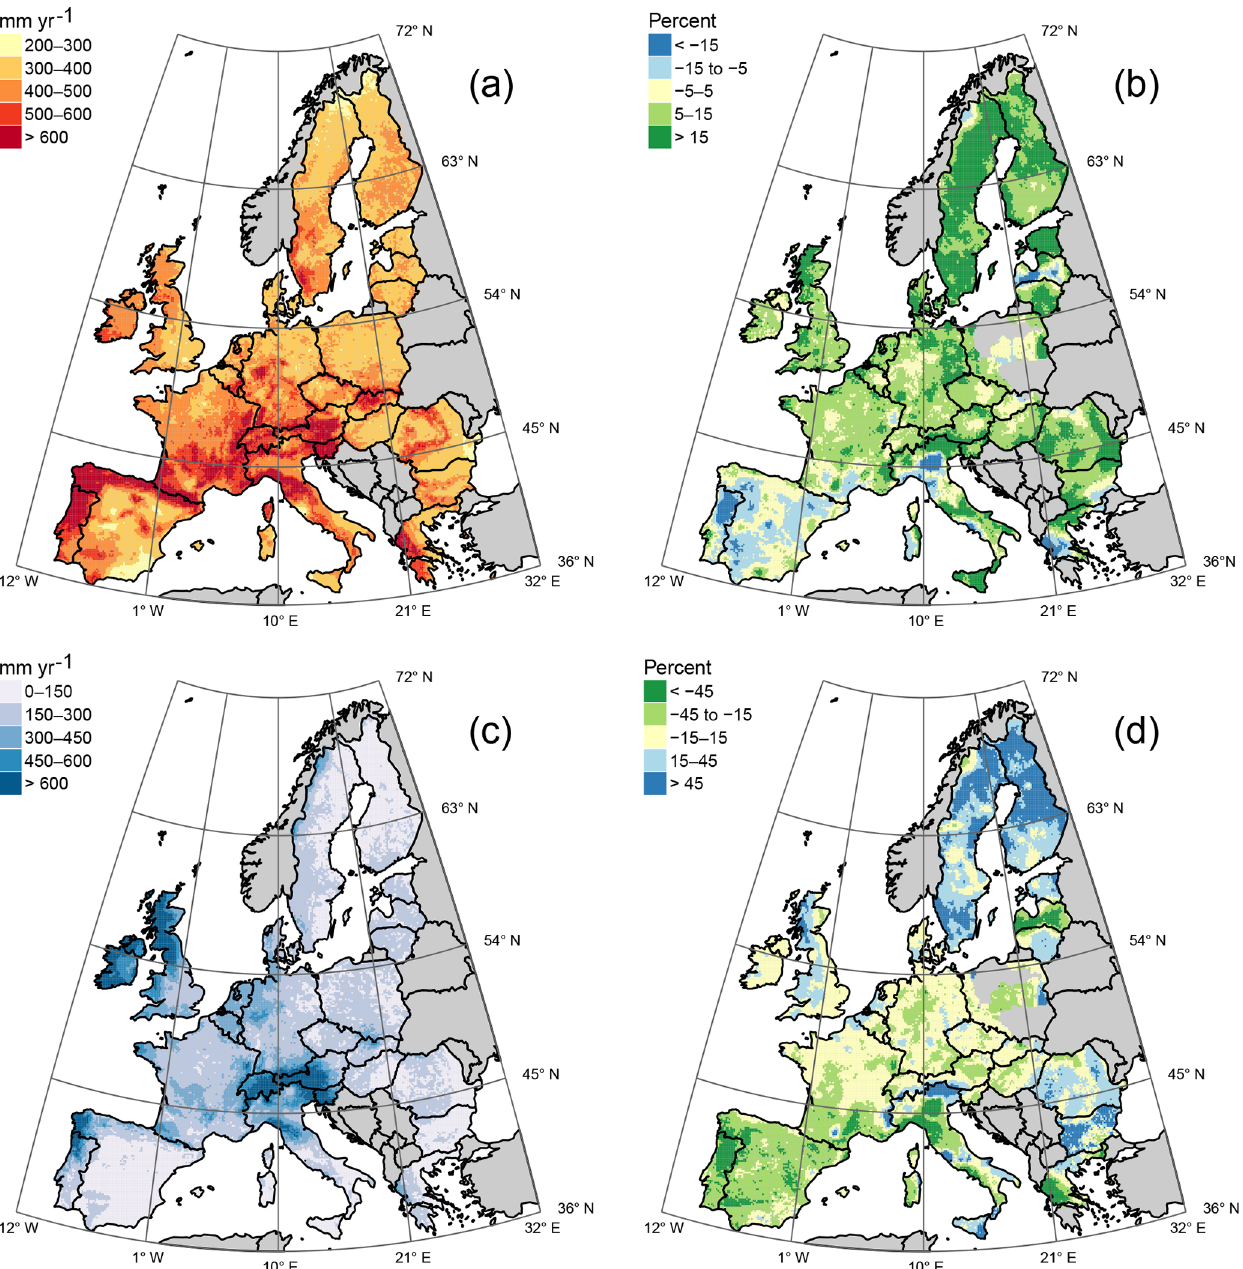
Figure 4. Simulated water balance partitioning over the period 1960–2010. Left panels show the mean evapotranspiration and streamflow in 1960 ( a and c , respectively), while the right panels indicate the change between the periods 1960 and 2010 for evapotranspiration (b) and streamflow (d)